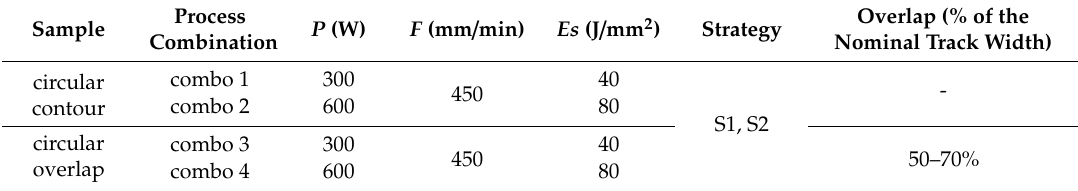
Table 2. LMD parameters used for the sample’s deposition.